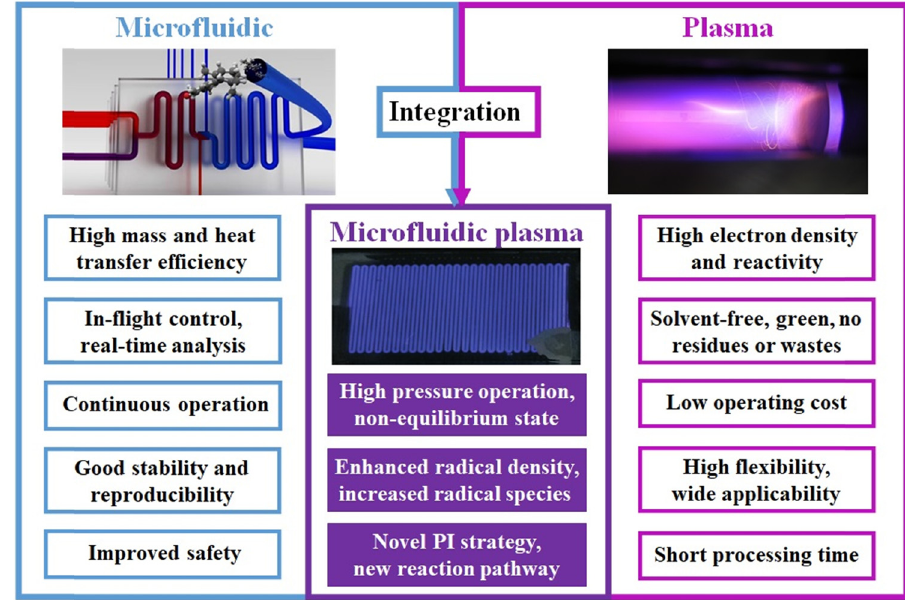
Figure 1: The advantages of micro fl uidic, plasma, and micro fl uidic